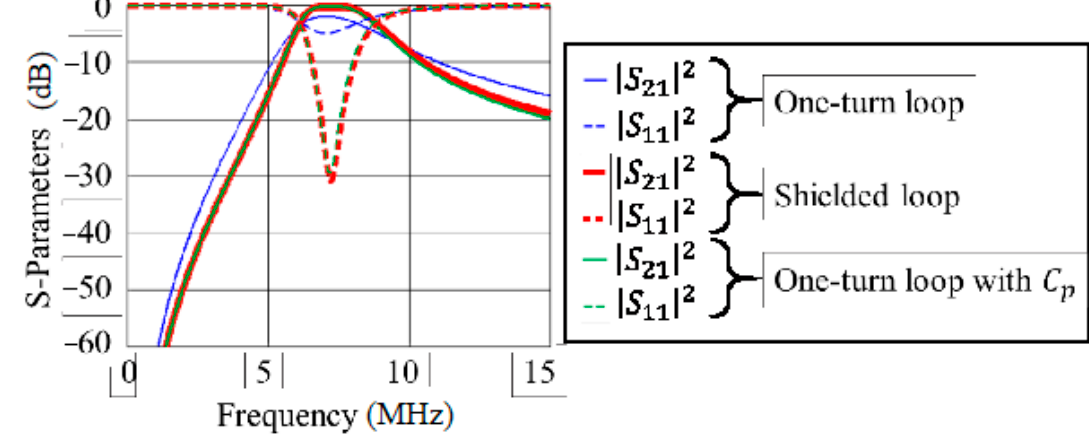
Figure 6. S parameters for frequencies of different coils.